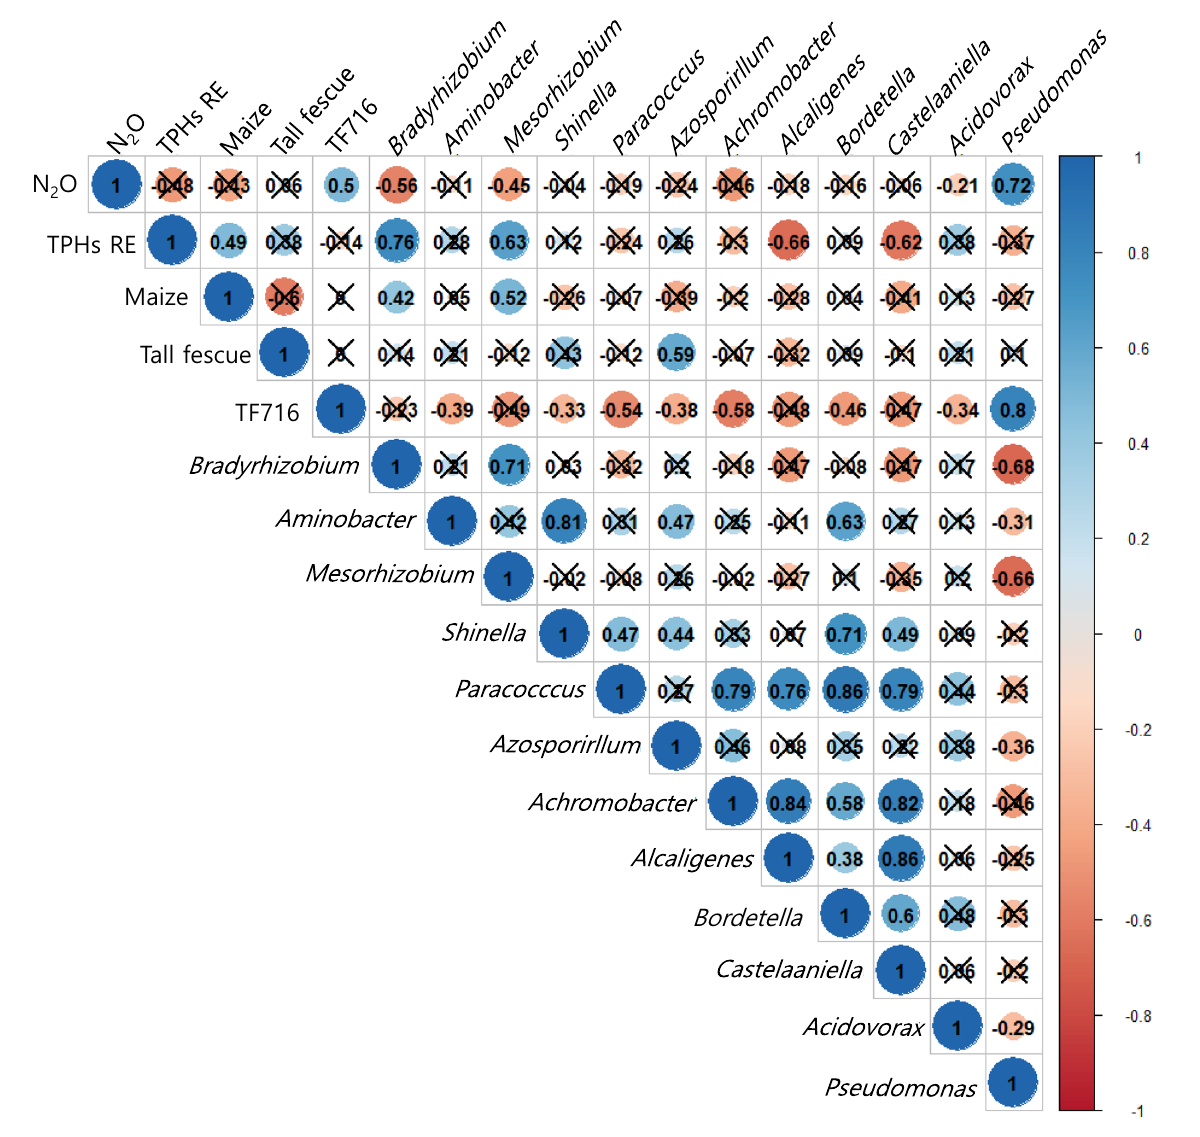
Figure 7. Pearson correlation between key parameters (N 2 O: N 2 O-reduction potential of the soil; TPHs RE: TPH-removal efficiency; Maize: maize planting; Tall fescue: tall fescue planting; TF716: Pseudomonas sp. TF716 inoculation; Genus-level bacteria: abundance of bacterial